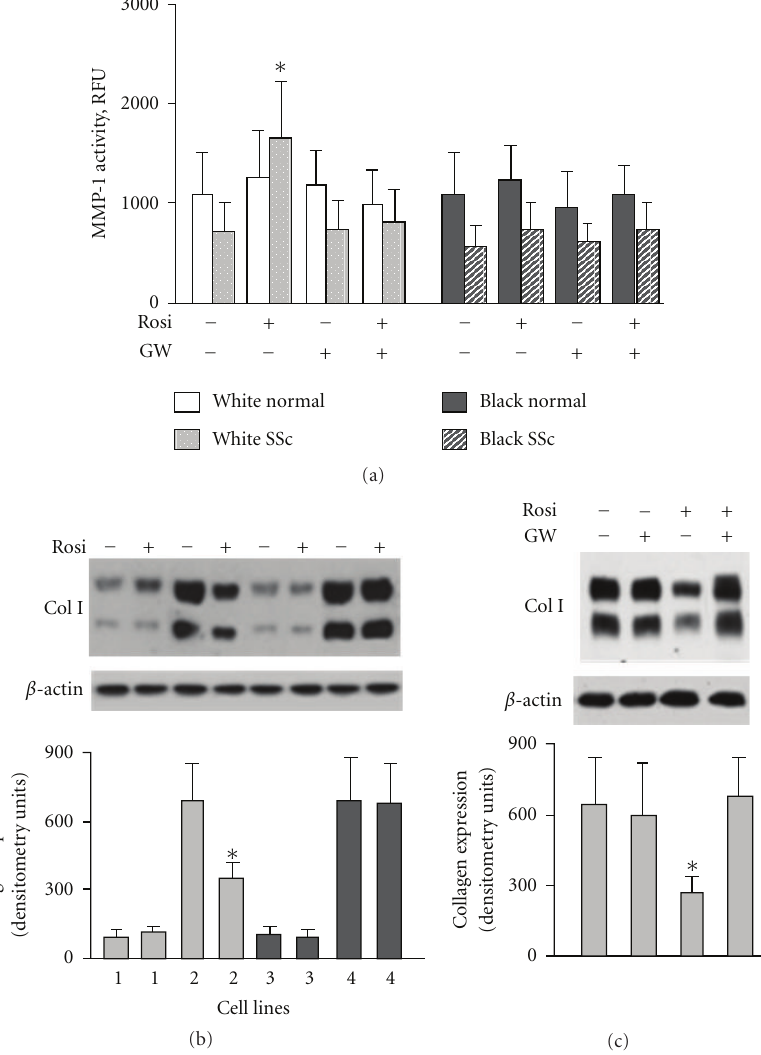
Figure 2: E ff ect of rosiglitazone on MMP-1 and collagen I in lung fibroblasts. (a) MMP-1 activity in lung fibroblasts. Each bar represents the mean and SD of duplicate determinations in 4 independent experiments. (b) E ff ect of rosiglitazone on collagen type I in white normal (1), white scleroderma (2), black normal (3), and black scleroderma (4) lung fibroblasts. (c) PPAR γ antagonist GW inhibits e ff ect of rosiglitazone on collagen in white scleroderma fibroblasts. Immunoblots in (b) and (c) are representative of 5 independent experiments. The results of immunoblot analysis were quantified. Values are the mean and SD of densitometry units corresponding to the α 1 and α 2 chains of type I collagen. ∗ P < 0 . 05 versus unstimulated